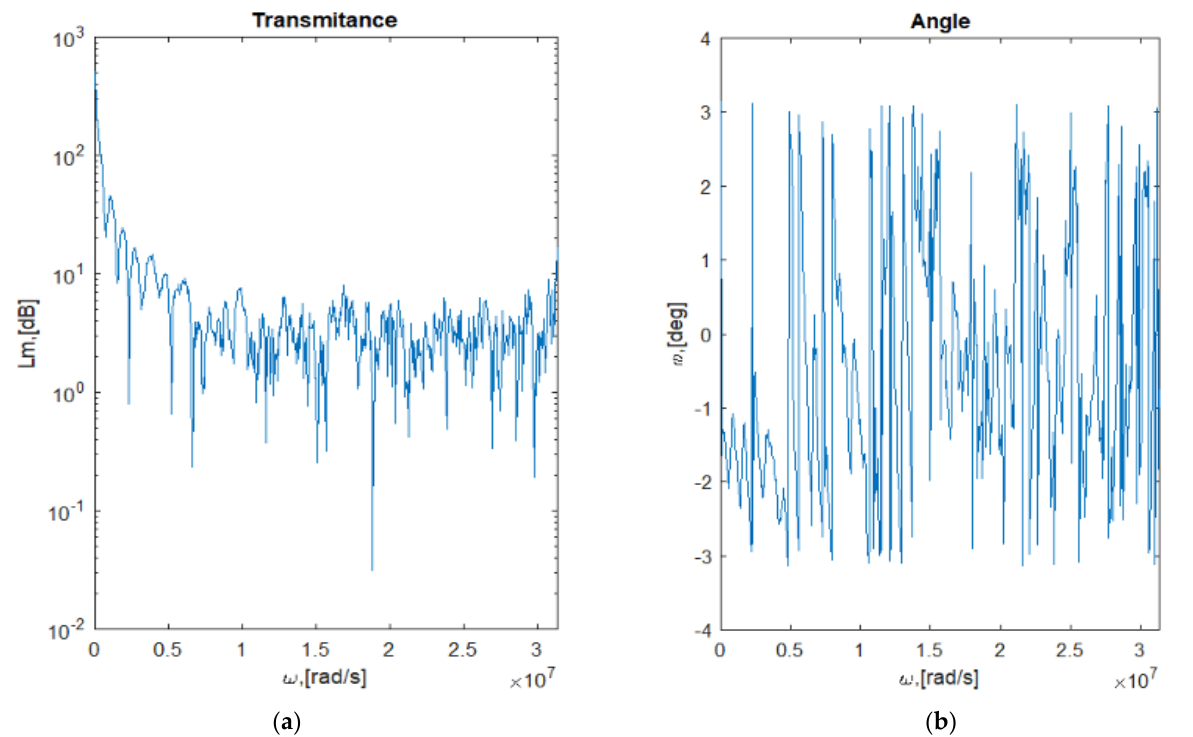
Figure 12. ( a ) Transmittance between pins A and B of the first motor and the engine control system terminals; ( b ) Angle of transmittance between pins A and B of the first motor and the engine control system terminals.